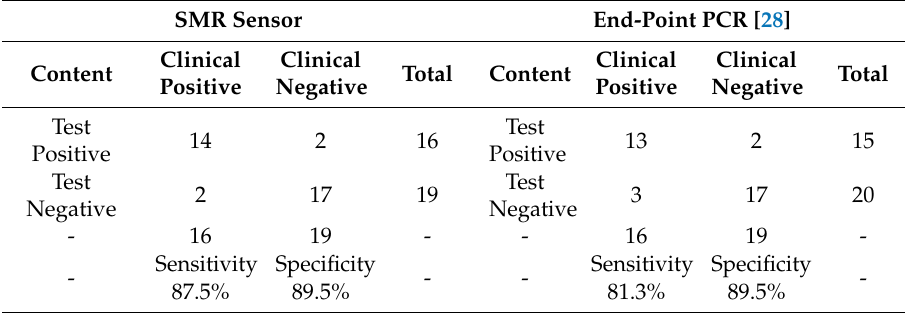
Table 3. The clinical sensitivity and specificity of the SMR biosensor for Q fever diagnosis using 35 clinical specimens at 10